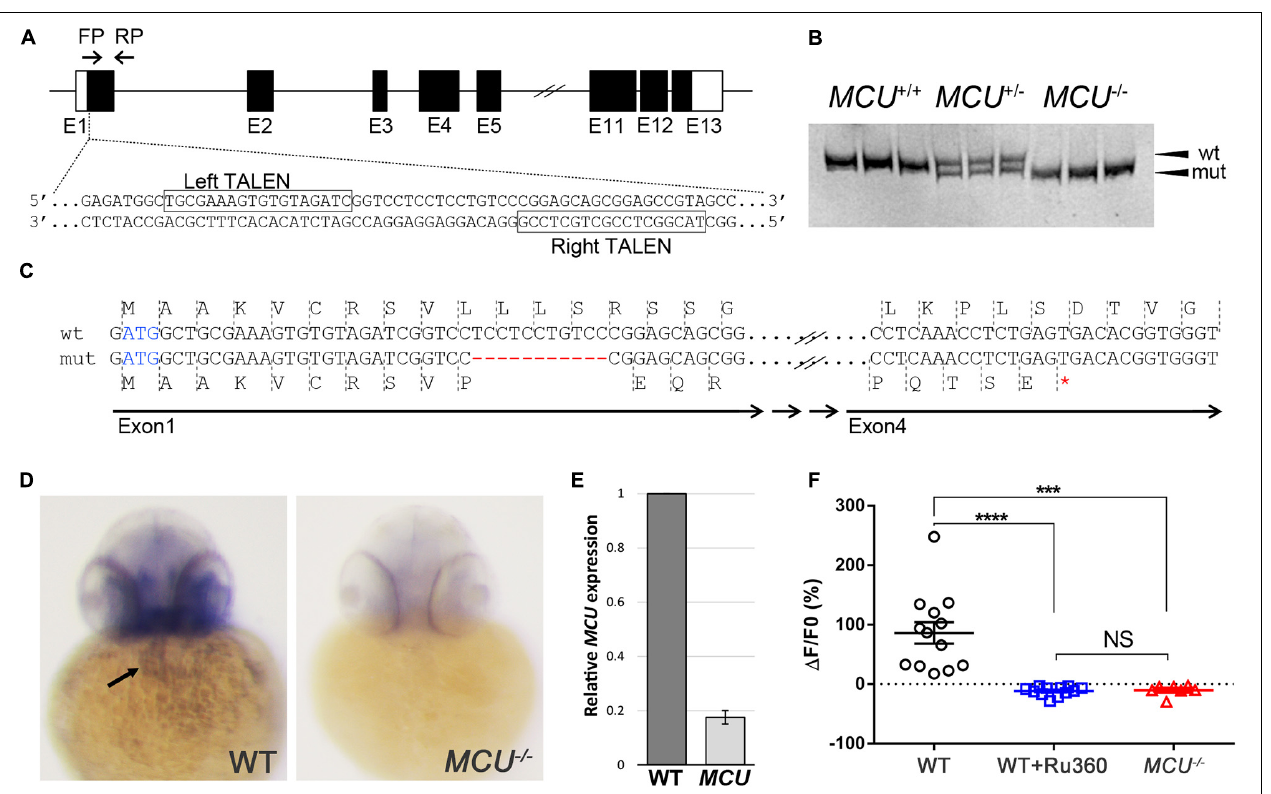
FIGURE 1 | Targeted mutation of MCU using TALENs. (A) Schematic representation of partial MCU genomic sequence demonstrating the TALEN binding sites. Open and solid boxes represent UTRs and coding exons, respectively. (B) Representative genotyping results. Amplification of the genomic region surrounding the deletion using a primer pair FP/RP shown in (A) . The wildtype (152 bp) and mutant (141 bp) fragments were separated using polyacrylamide gel electrophoresis. (C) Sequencing analysis of cDNA identified a frameshift mutation caused by an 11-nucleotide deletion in exon 1, resulting in a premature termination of translation. (D) In situ hybridization detects MCU transcripts in the heart (arrow) in WT but not mcu mutant embryos at 3 days post fertilization (dpf). (E) Quantitative PCR analysis of MCU transcripts in 3 dpf embryos. (F) Quantification of Rhod 2 Signals in WT cardiomyocytes with and without MCU inhibitor Ru360 and MCU mutant cardiomyocytes. **** p < 0.0001; *** p < 0.001; and NS: p >